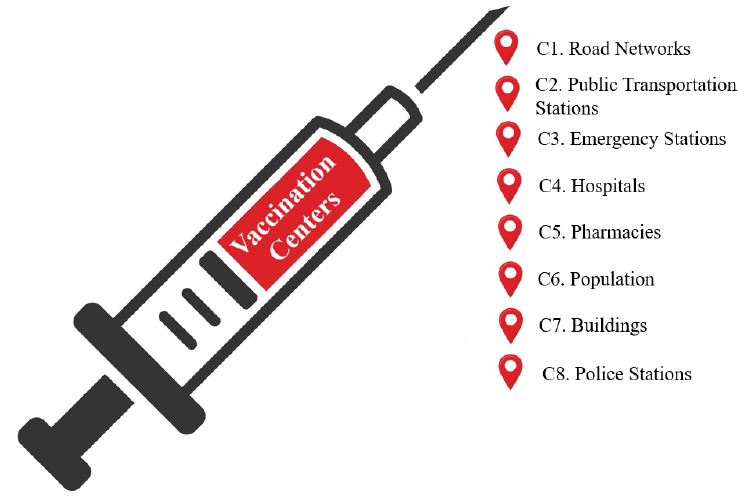
Figure 4. Evaluation criteria for vaccination centre.